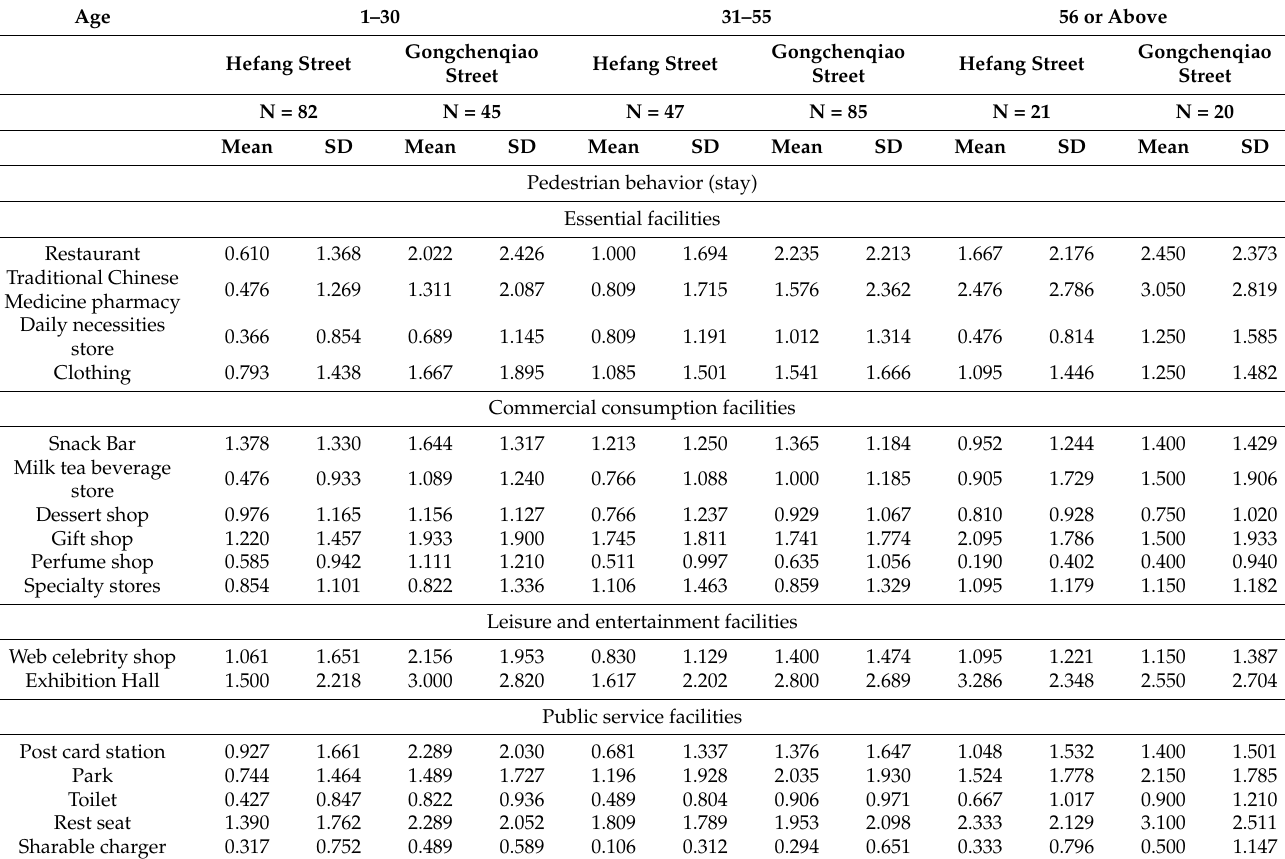
Table 4. Mean and standard deviation of dwell time for pedestrian street facilities of different